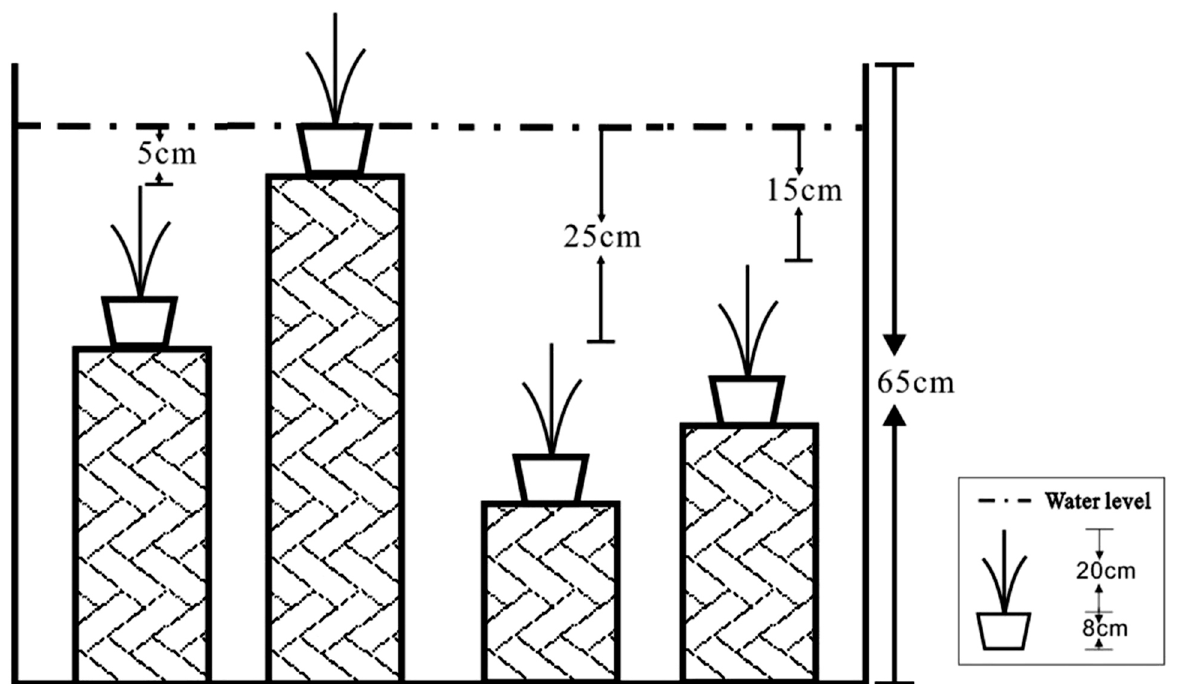
Fig 1. The schematic diagram of the experimental